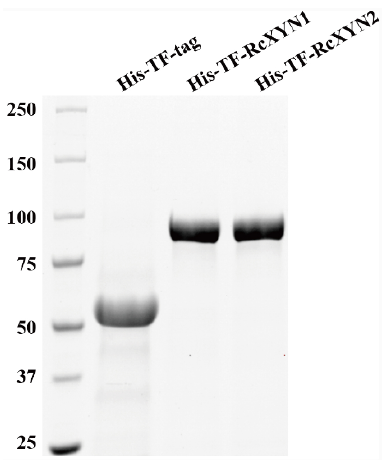
Figure 5. Heterologous expression of RcXYN1 and RcXYN2 in Escherichia coli . Sodium dodecyl sulphate-polyacrylamide gel electrophoresis (SDS-PAGE) patterns of the purified His-TF-RcXYN1 and His-TF-RcXYN2. His-TF-tag is the control sample.